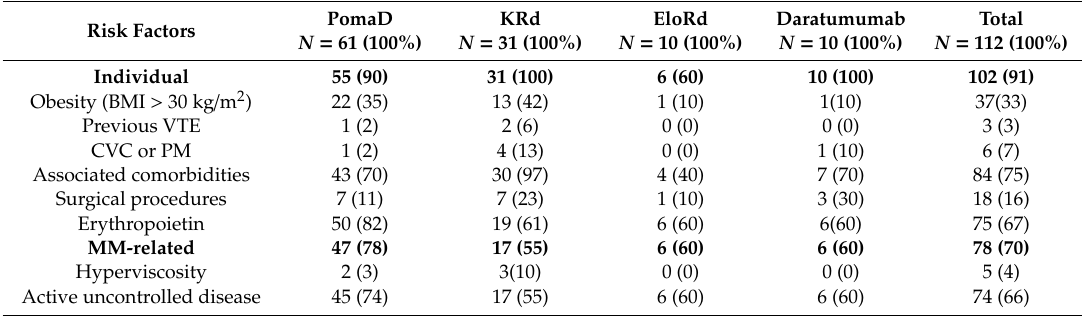
Table 2. Data on individual, MM-related and anti-MM therapy-related VTE risk